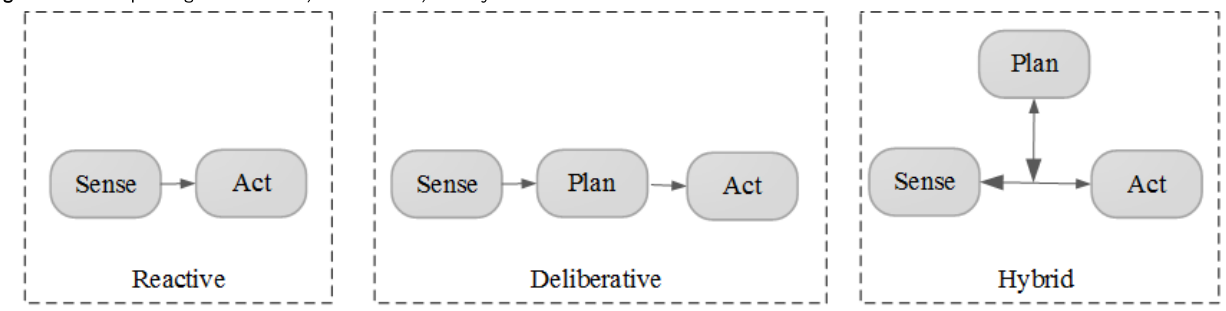
Figure 3. Three paradigms: Reactive, Deliberative, and Hybrid.